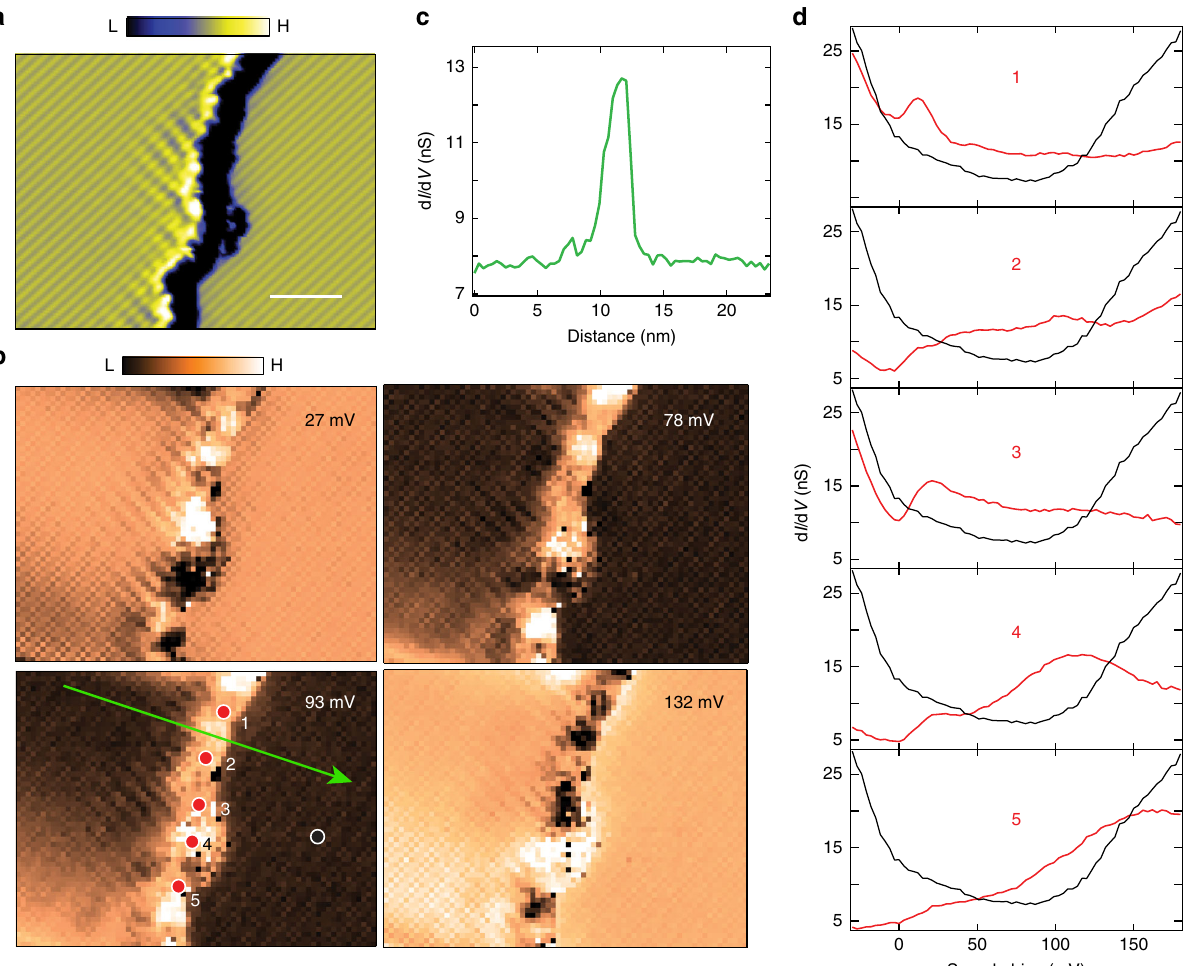
Fig. 3 Edge states of WTe 2 residing at an irregular shaped step edge. a Derivative STM image of a single layer high step edge with irregular shape. The scale bar is 5 nm. Measurement conditions: V s = 180 mV, I t = 200 pA. b Spectroscopic mapping of the imaged area in a at different voltages, showing the spatial distribution of the edge state with energy. c A sectional line pro fi le extracted from b along the green line . d Tunneling spectra ( red curves ) at different locations of the step edge ( red dots in b ). The spectroscopy ( black curve ) of the inner terrace ( black dot in b ) is shown for comparison. Measurement conditions of b , d : V s = 180 mV, I t = 600 pA, V mod = 3.5 mV